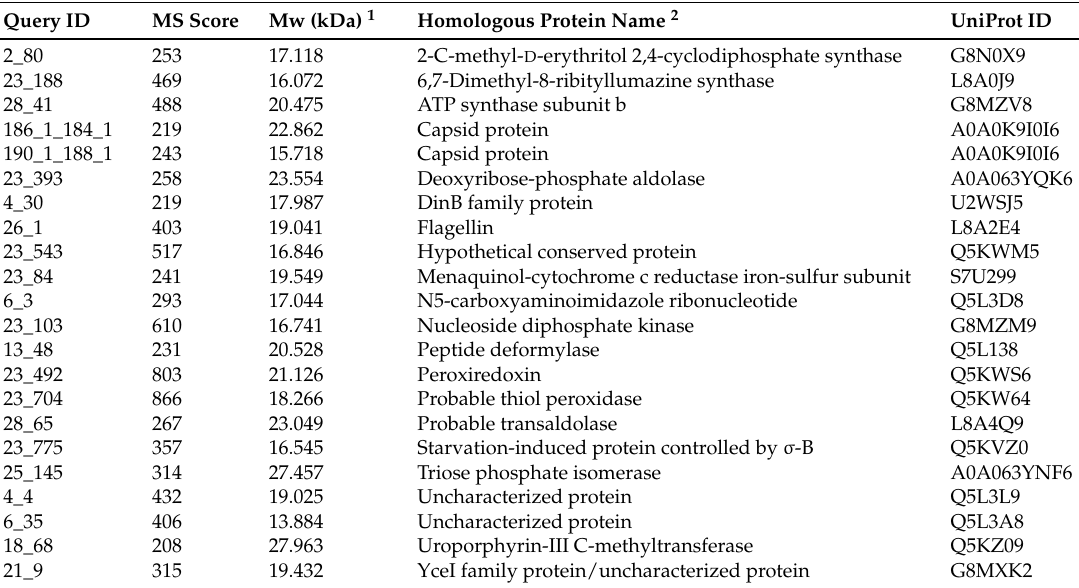
Table 1. Proteins (10–30 kDa) identified by mass